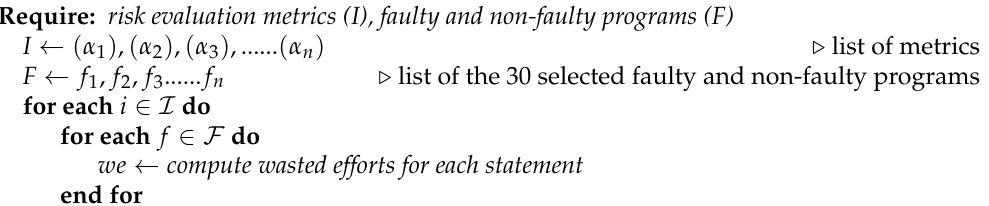
Algorithm 1 Metrics